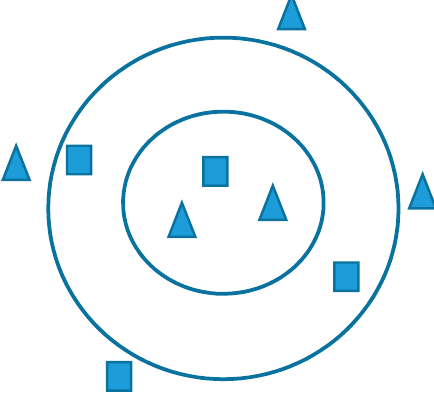
Figure 6. KNN algorithm for a situation with two classes and two features.